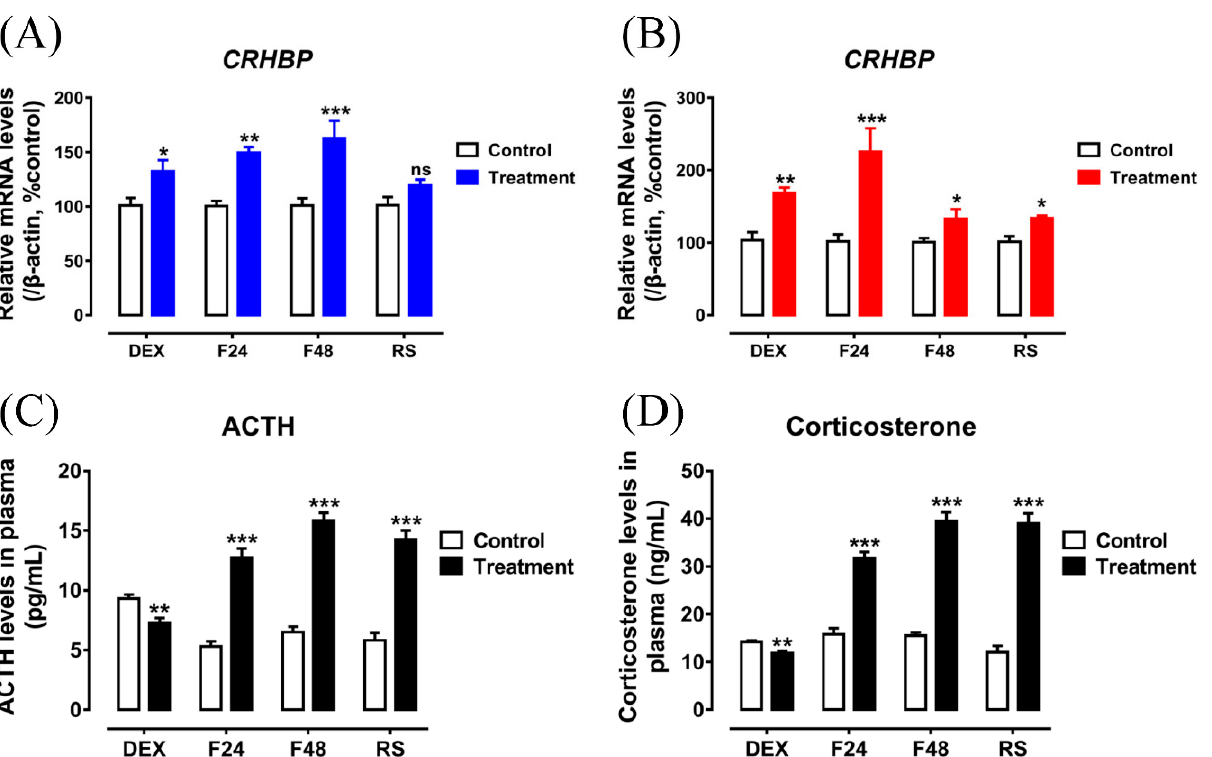
Figure 8. ( A , B ) The effects of different stress treatments on cCRHBP mRNA expression in the